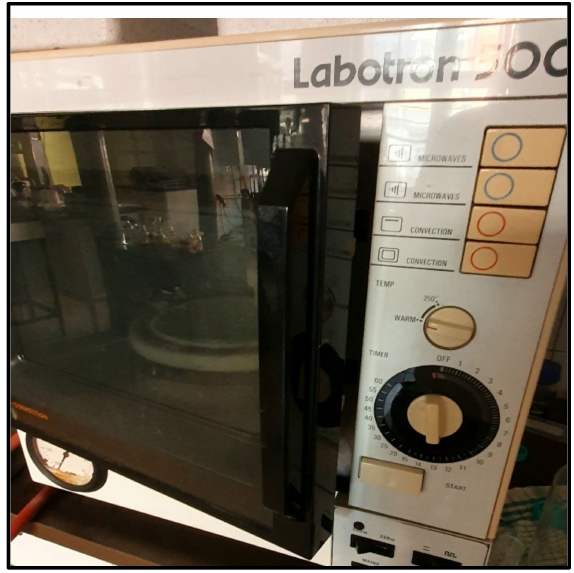
Figure 6. Labotron 500 laboratory grade batch microwave